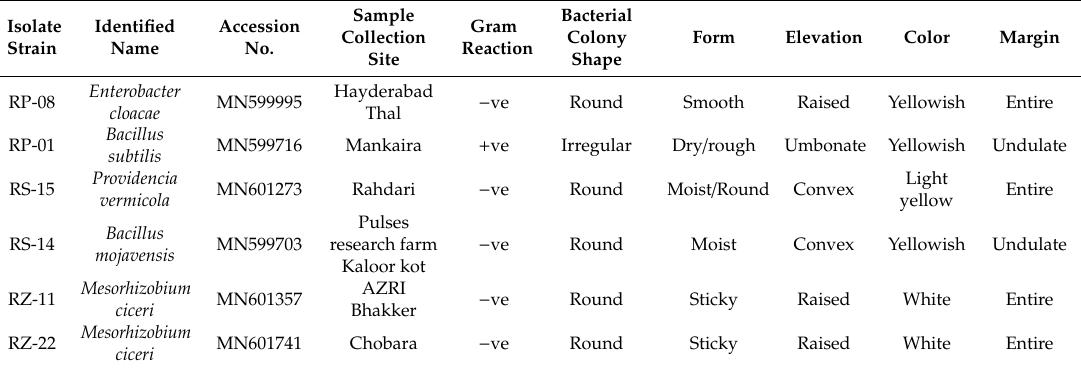
Table 1. Morphological characterization of most e ffi cient isolated bacterial strains after